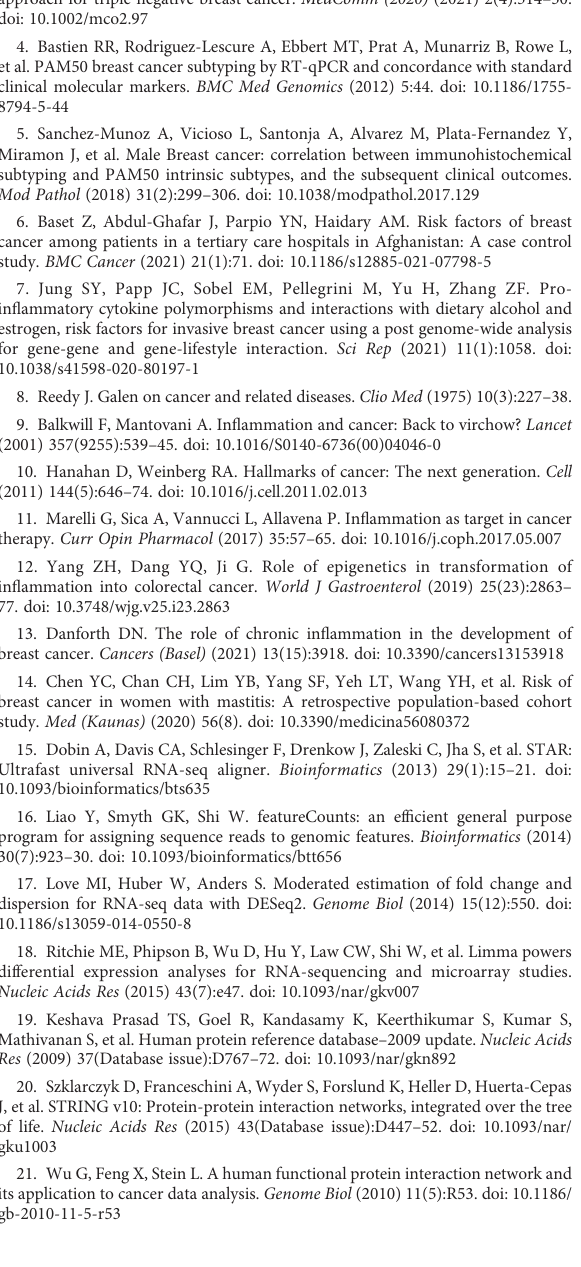
SUPPLEMENTARY FIGURE 4 erythroid cell in fi ltration in in fl ammation and ER − breast cancer. (A) The absolute score of erythroid cells among different breast tissues. “ ns ” ,